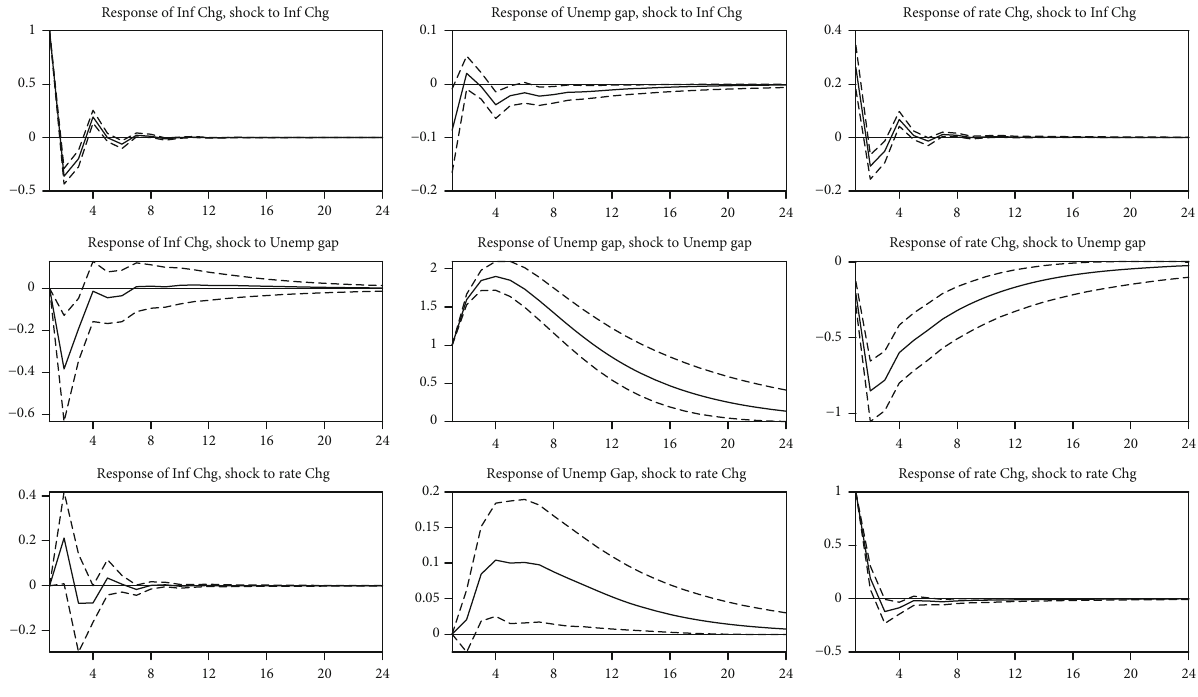
Figure 4: The NAIRU theory impulse response